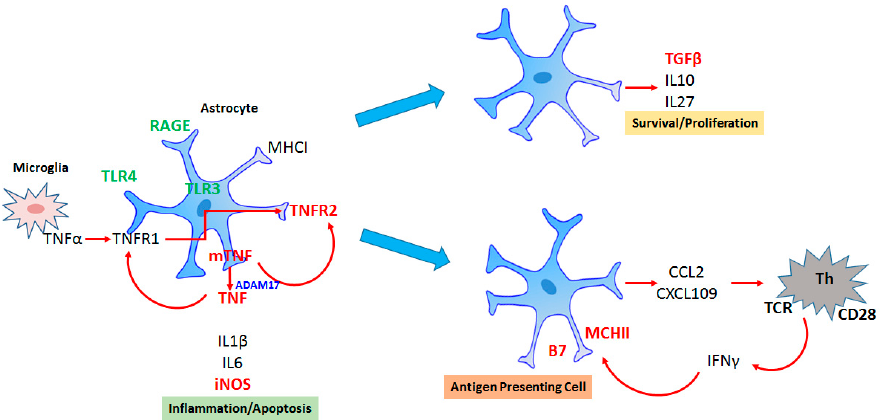
Figure 1. Heterogeneity of reactive astrocytes during inflammation. Astrocytes respond directly to inflammatory stimulus (e.g., via TLR4: toll like receptor 4 or indirectly to inflammatory cytokines by cytokine receptors. In basal conditions, they secrete small quantities of cytokine TNF (tumor necrosis factor) and express only TNFR1 (tumor necrosis factor receptor 1). When exposed to inflammation, TNF production is increased, as well as the expression of TNFR2, which is commonly expressed by immune cells. TNFR2-astrocytes can generate both anti-inflammatory astrocytes able to express TGF (tumor growth factor) and IL-10 and pro-inflammatory astrocytes which are able to release chemokines and attract T lymphocytes, which, in turn, release interferon gamma (IFN γ ), inducing the expression of MCH class II in astrocytes, and transforming them into antigen-presenting